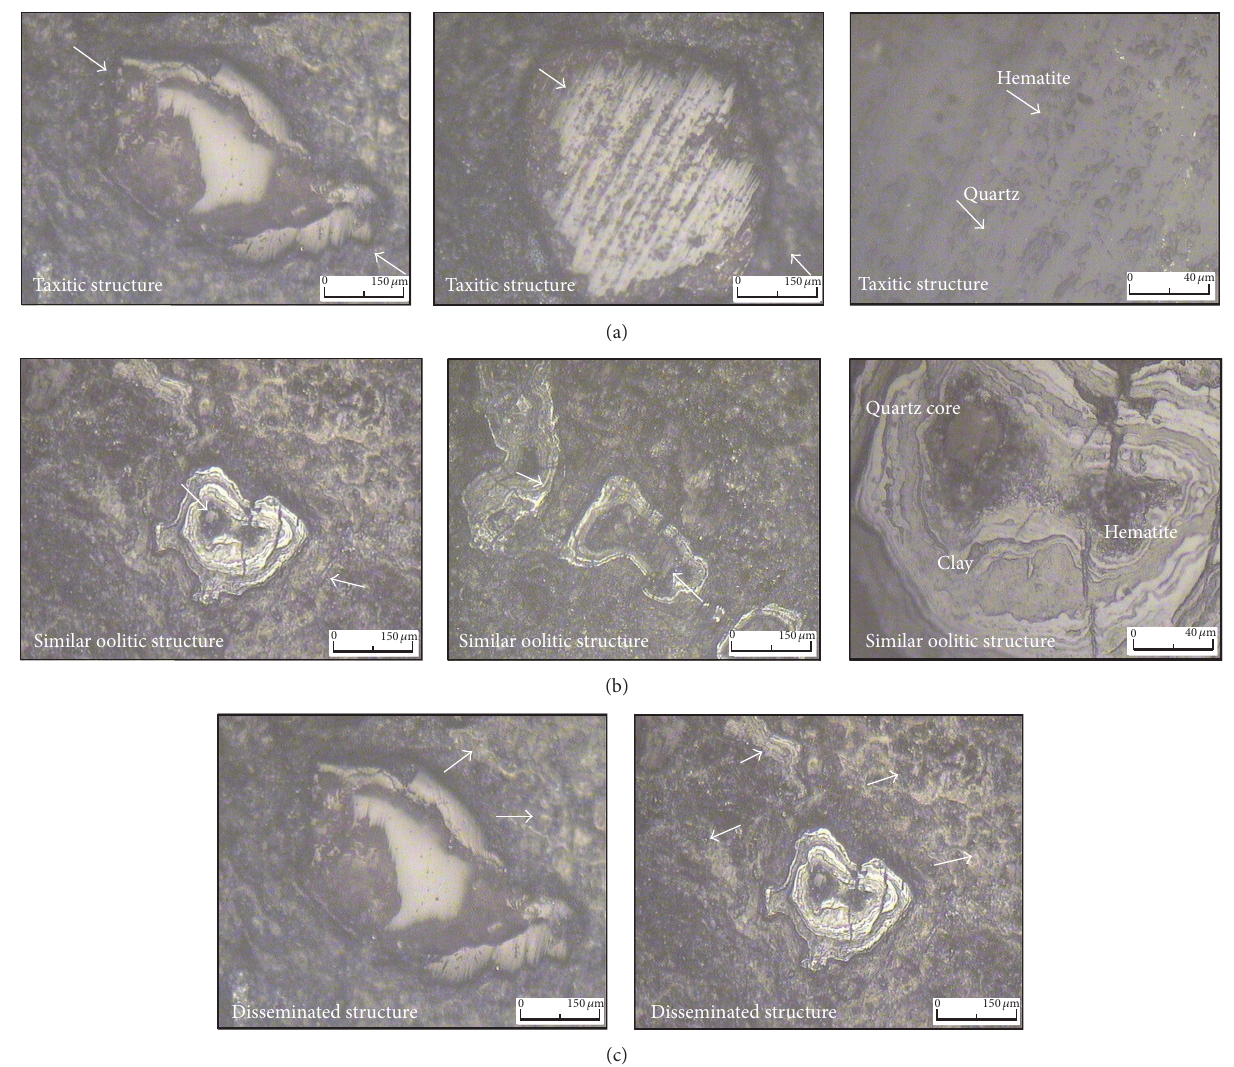
Figure 3: Optical microscope images of the raw hematite